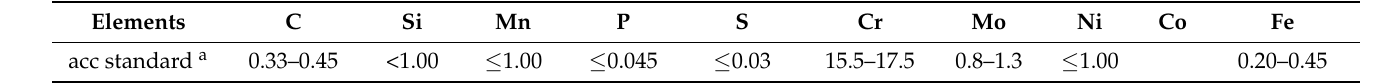
Table 4. Chemical composition of 1.4122 (X35CrMo17), in mass percent.